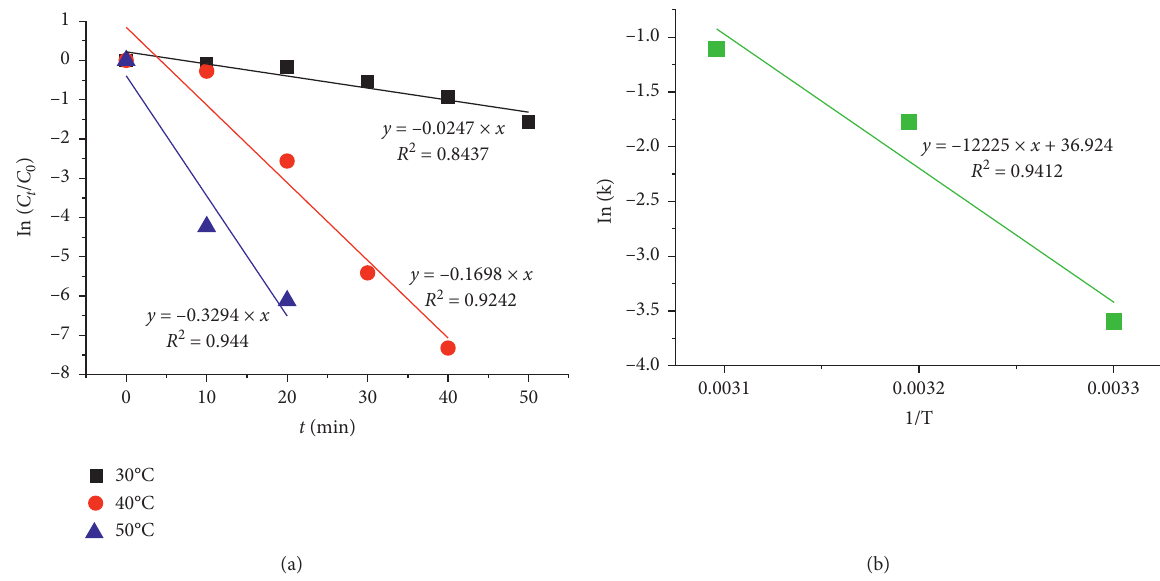
Figure 14: (a) Pseudo-first-order kinetic plots of the degradation of MO by the heterogeneous UV/Fenton-like MIL-53 catalyst at different reaction temperatures; (b) Arrhenius plots.